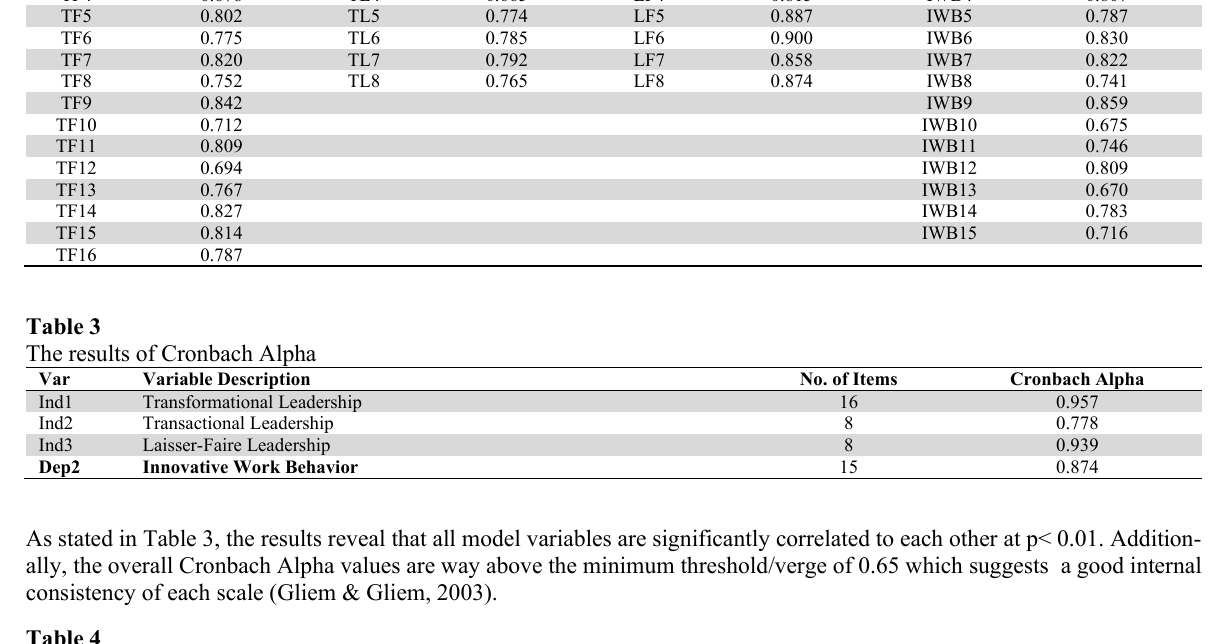
The summary of Pearson Correlation Coefficient between leadership styles and employees’ innovative work behavior